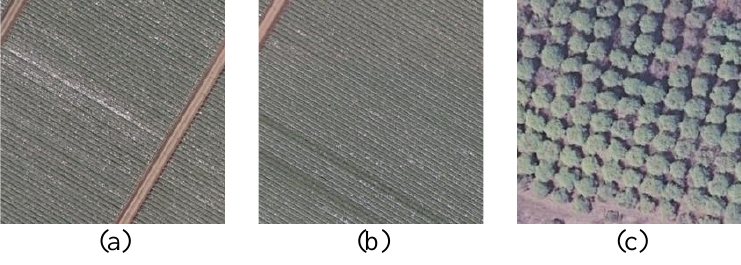
Figure 3. Three “Agricultural” remote sensing images selected from the UCMerced archive